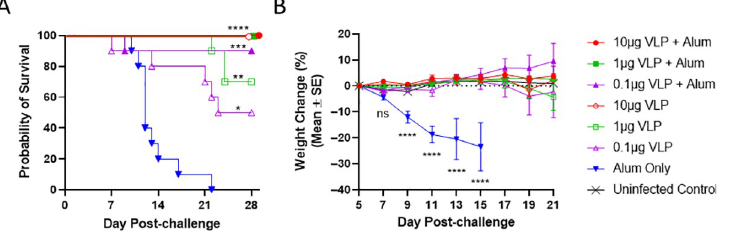
Fig 3. Survival and weight loss following lethal ZIKV challenge. On day 44 of the study, mice were given an SC challenge of ~100 CCID 50 of ZIKV strain PRVABC59. (3A) Survival was monitored for 28 days and survival rates for each VLP group were compared to the alum only (100 μ g) group by Fisher’s exact test with significance levels denoted as: ���� P < 0.0001, ��� P < 0.001, �� P < 0.01, � P < 0.05, or ns (not significant). (3B) Weight loss was monitored for 16 days starting at day 5 post-challenge. Group mean weight loss is shown as a percentage relative to day 5 post-challenge with error bars denoting group standard error of the mean for ease in viewing. An uninfected control group (n = 5) is shown for comparison and the dotted line indicates zero change. Weight changes were compared on days 7 through 15 by one-way ANOVA, and comparisons to the alum only group were by Dunnett’s multiple comparison tests with significance levels denoted as for Fig